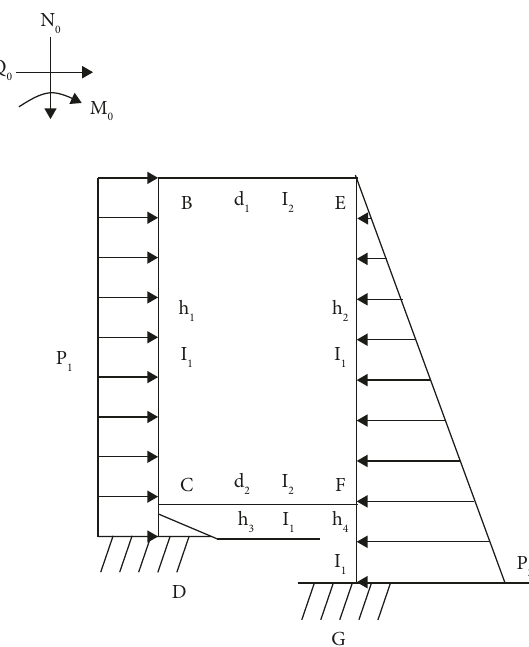
Figure 9: Schematic diagram of middle frame segment calculation.